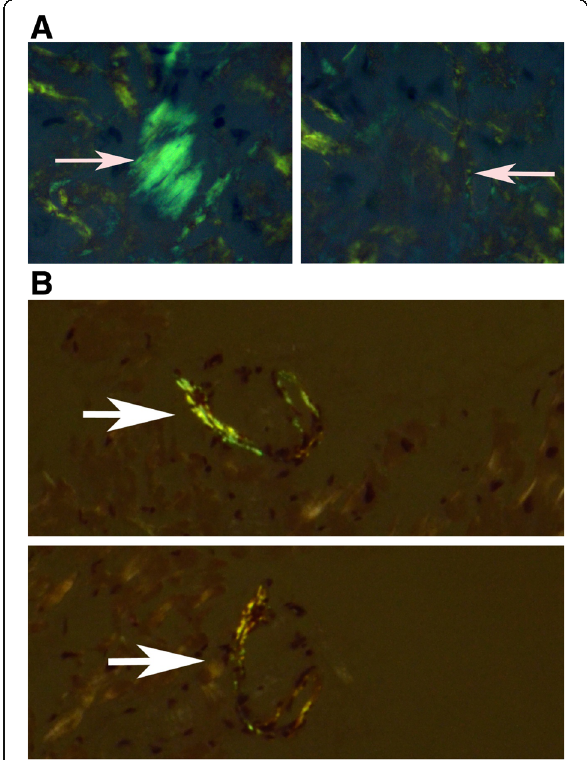
Fig. 4 shows a sample imaged then re-images after rotating the stage. 4A rotated 45 degrees and 4b rotated 60 degrees. The green birefringence is no longer visible as indicated by the